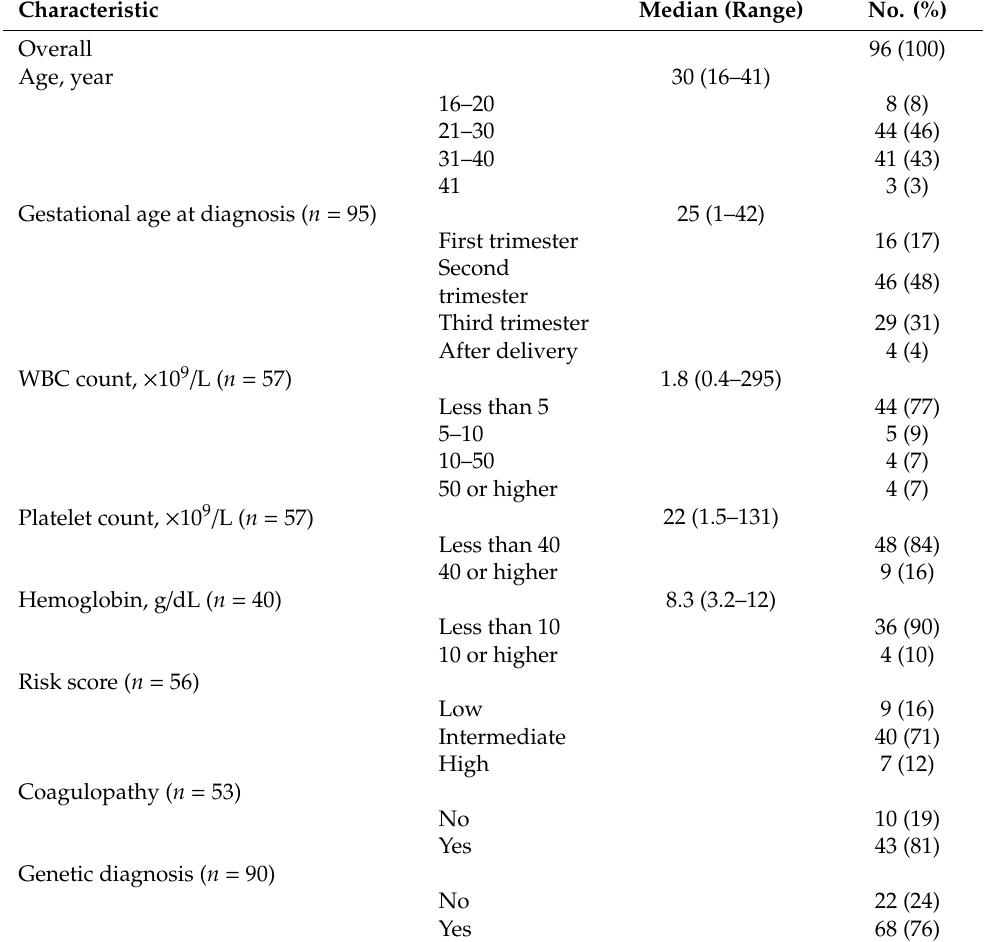
Table 2. Characteristics of patients with APL presenting during pregnancy.